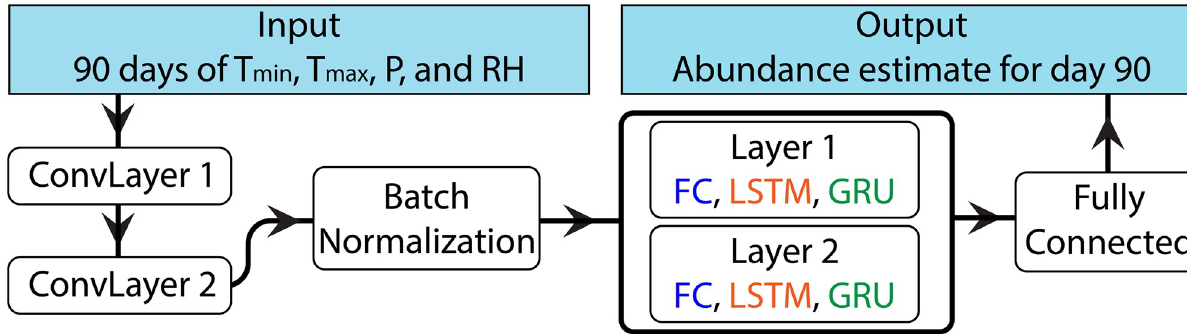
Fig 2. Architecture of the models used in this